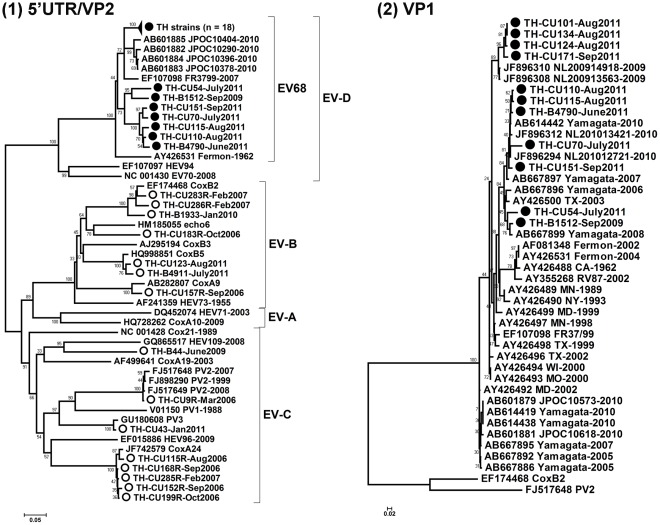
Neighbor-joining (NJ) estimate of phylogenetic relationship for human enteroviruses detected among Thai pediatric children during 2006–2011.The NJ trees were constructed from nucleotide alignments of (A) the 5′UTR/VP2 (612 nt) and (B) partial VP1 region (257 nt) using MEGA software. The genetic distances were calculated according to the Kimura-parameter model. Bootstrap support values with 1000 pseudo-replicates were plotted at the internal branch nodes. EV species A to D were labeled. Period of the sample collection was plotted for each lineage. EV68 and other EVs identified in this study (TH-strain) are indicated in black and white circles, respectively. Virus sequence names or location of isolations shown with GenBank accession numbers were reference strains. Scale bar indicates number of nucleotide substitutions per site.